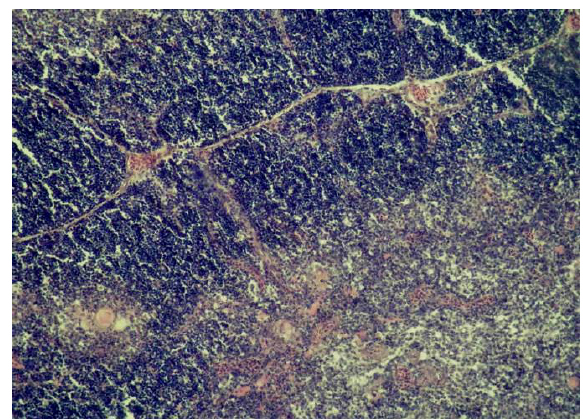
(Fig. 4). Interlobular connective tissue layers are thickened, large size.